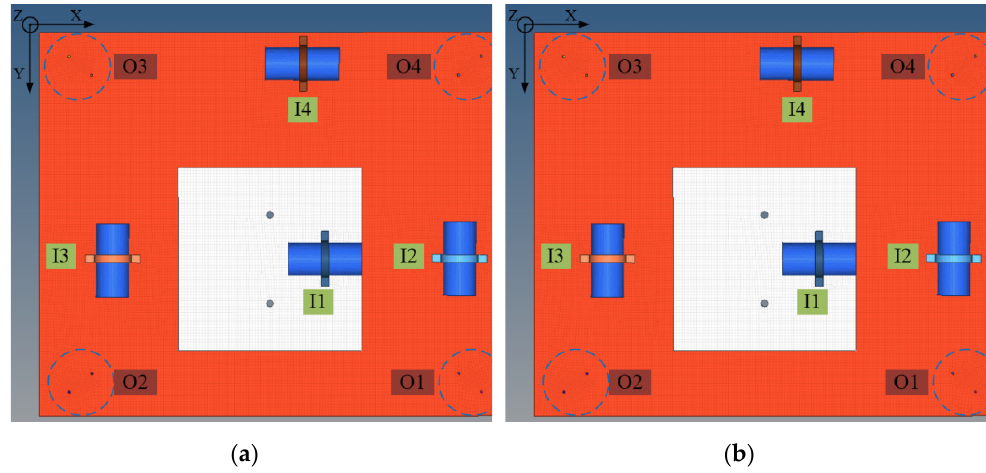
Figure 3. The overall finite element model of the satellite refrigeration module: ( a ) Positive; ( b ) Negative.